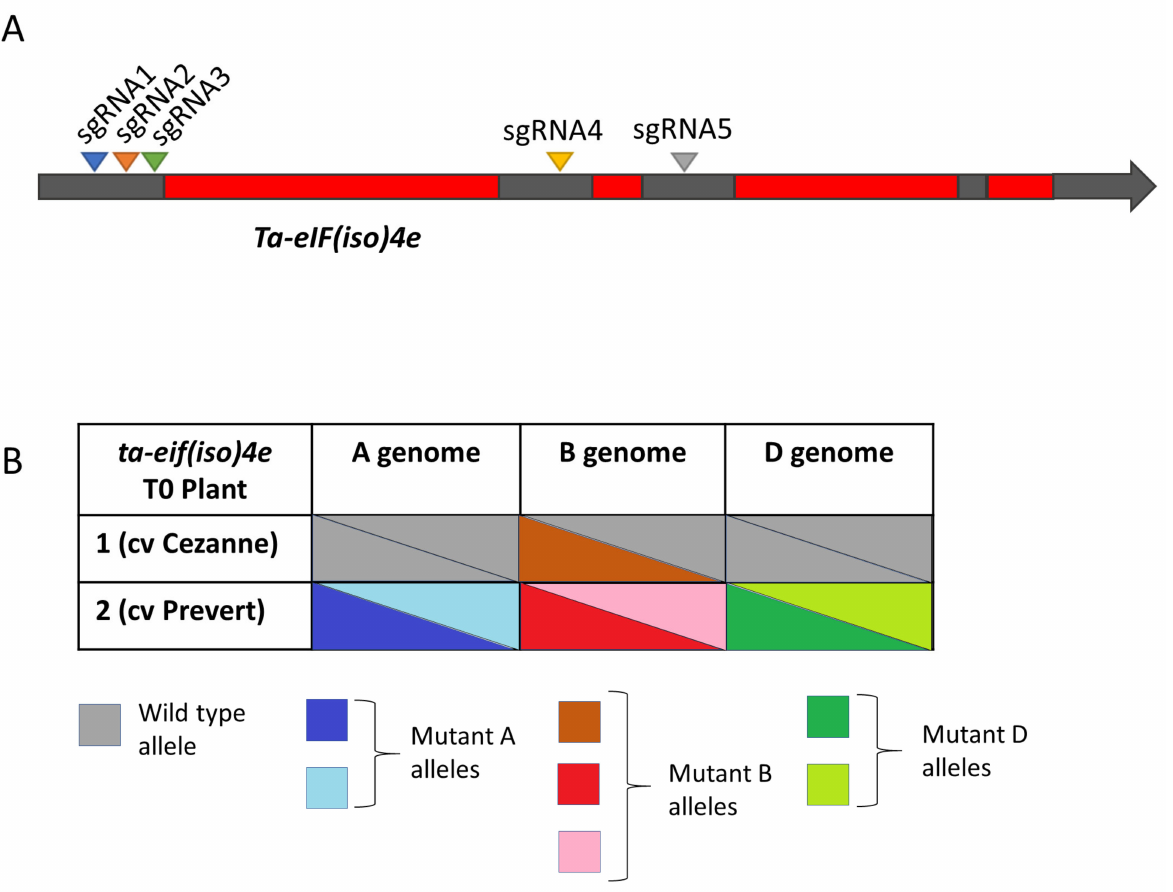
Figure 4. Targeted mutagenesis of Ta-eIF(iso)4e . ( A ) Cartoon showing locations of sgRNA target sites and ( B ) allele composition of ta-eif(iso)4e T0